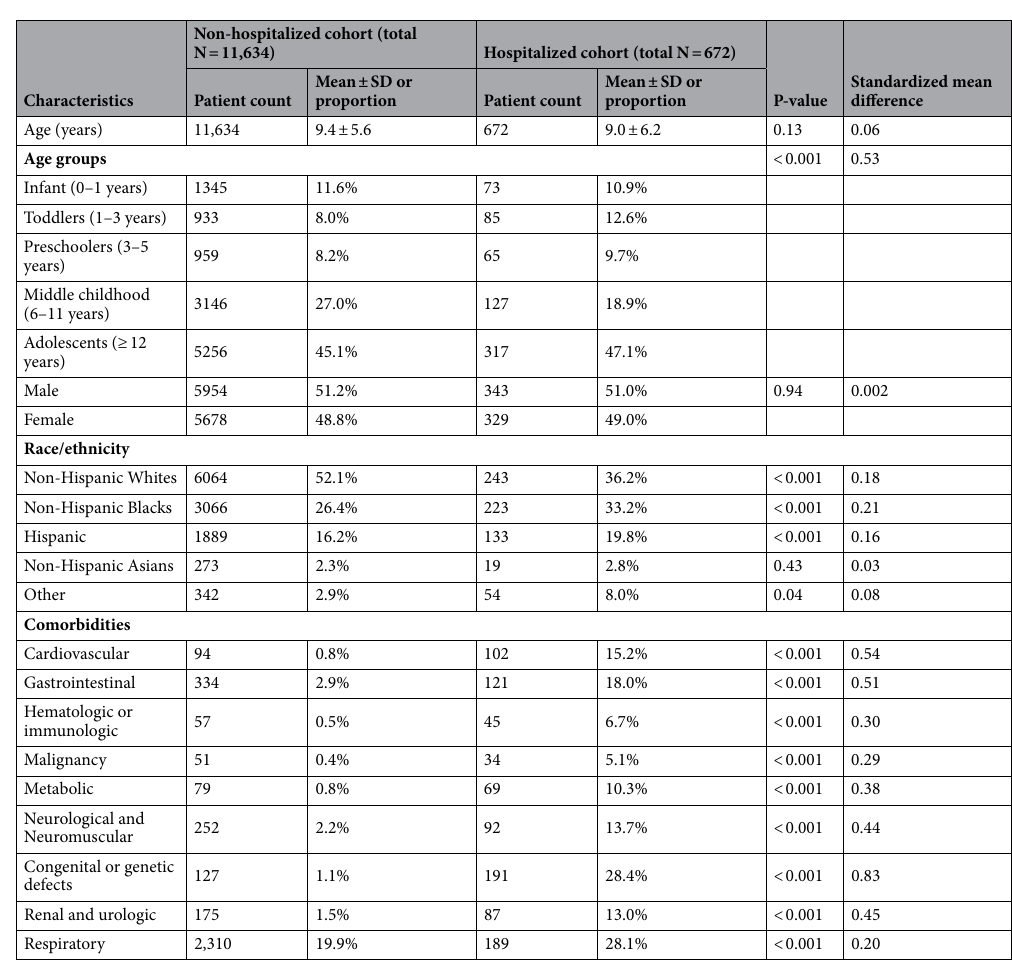
Table 1. Baseline characteristics of the overall cohort. SD standard